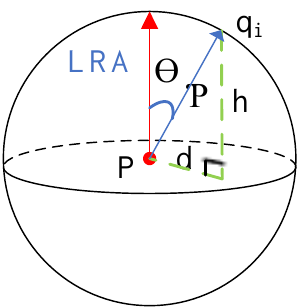
Figure 1. Two ways to encode spatial information by an LRA.